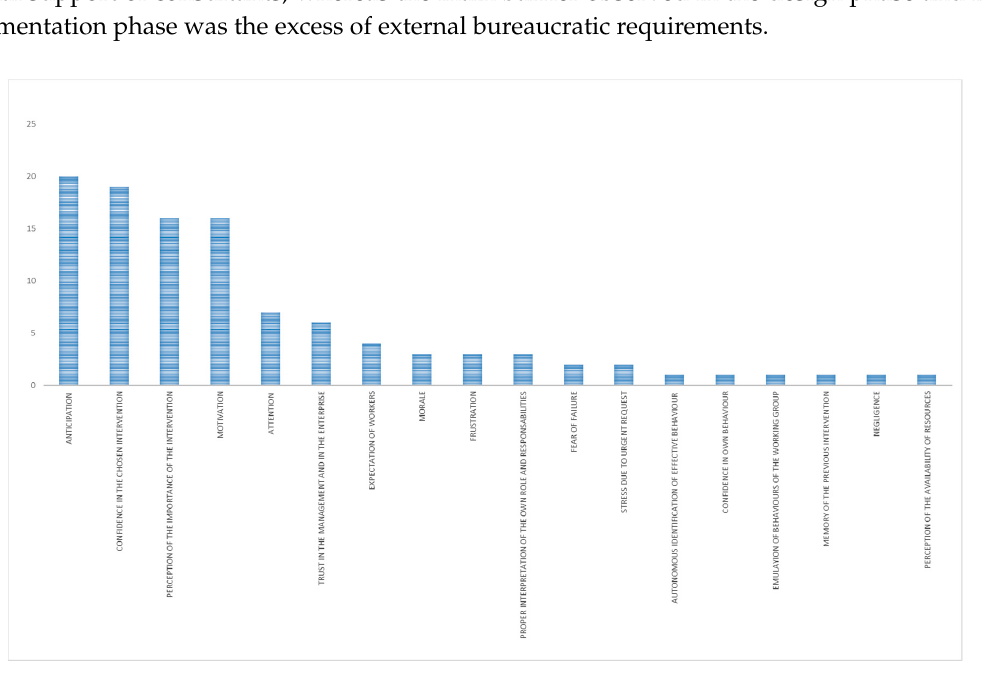
Figure 5. Main mechanisms (in terms of number of occurrences) in organizational interventions with expected outcome.